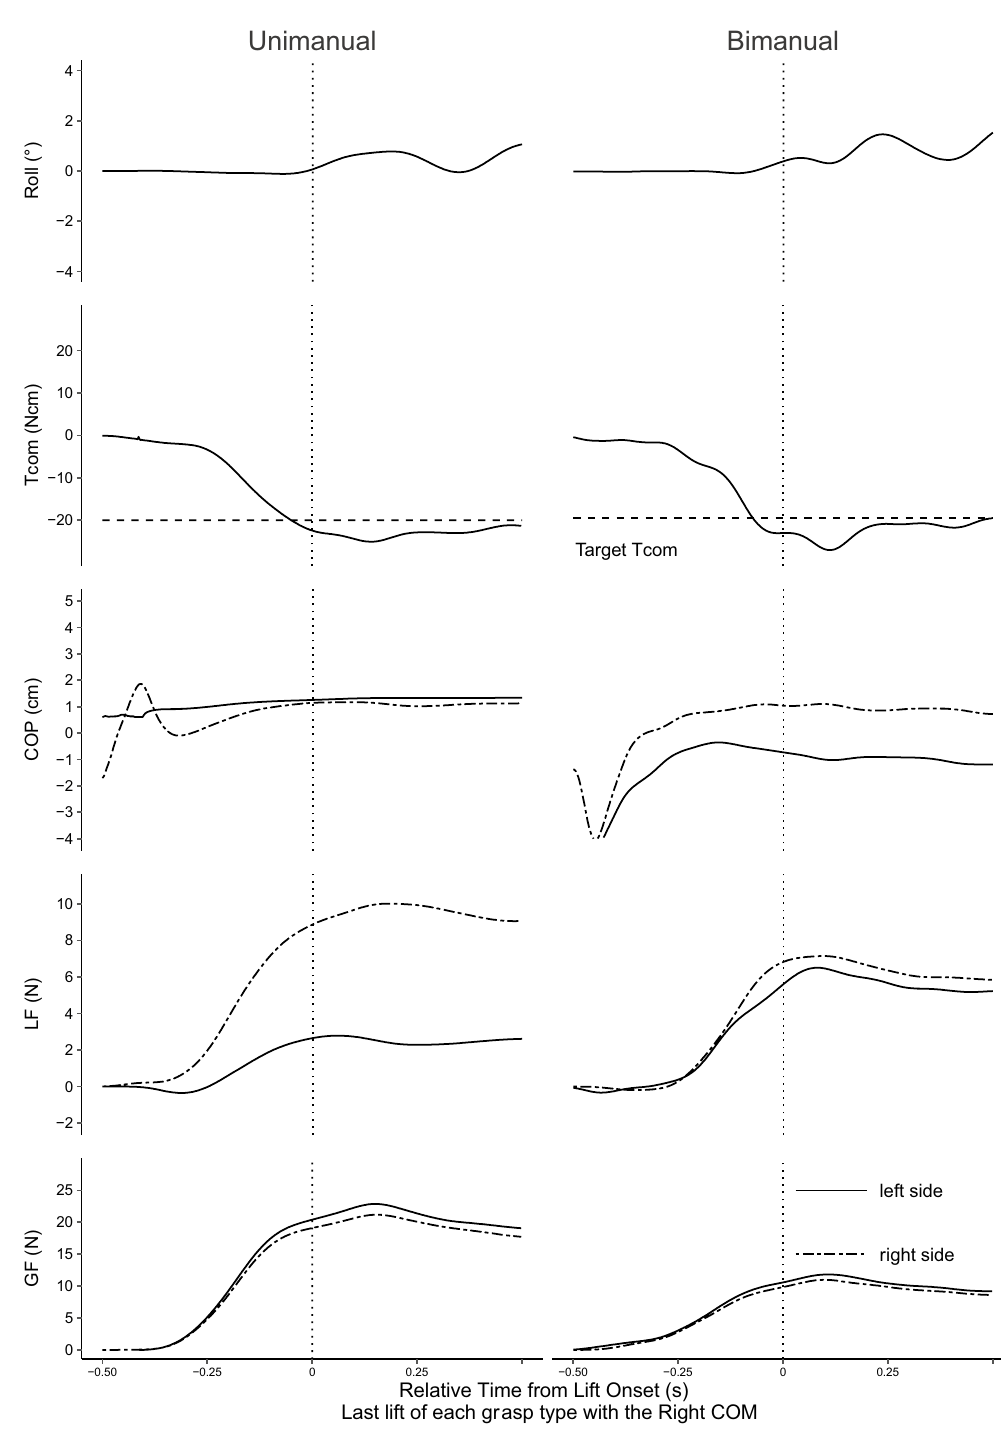
Figure 3. Representative plots for the right center of mass (COM). Traces for the learned trials of all measures for the unimanual and bimanual grasps. Tcom = compensatory torque, COP = center of pressure, LF = load force, GF = grip force. Vertical dotted lines represent time at lift